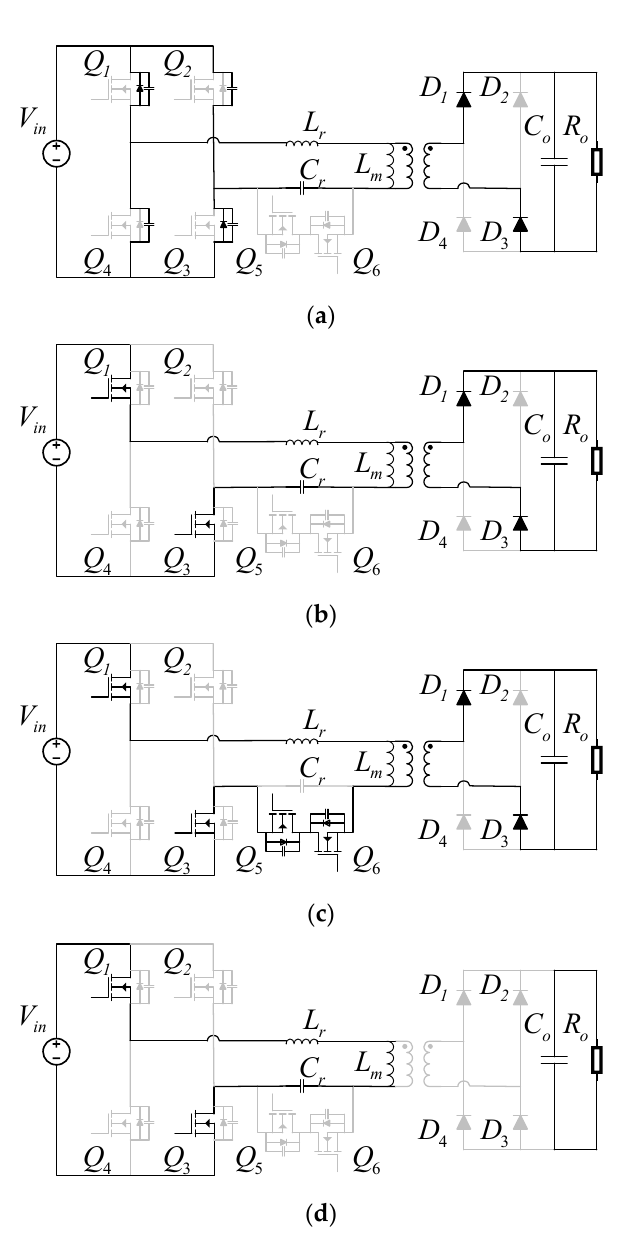
Figure 5. Conduction circuit of the LLSC converter in the boost mode. ( a ) Stage 1; ( b ) Stages 2, 3 and 5; ( c ) stage 4; and ( d ) Stage 6.